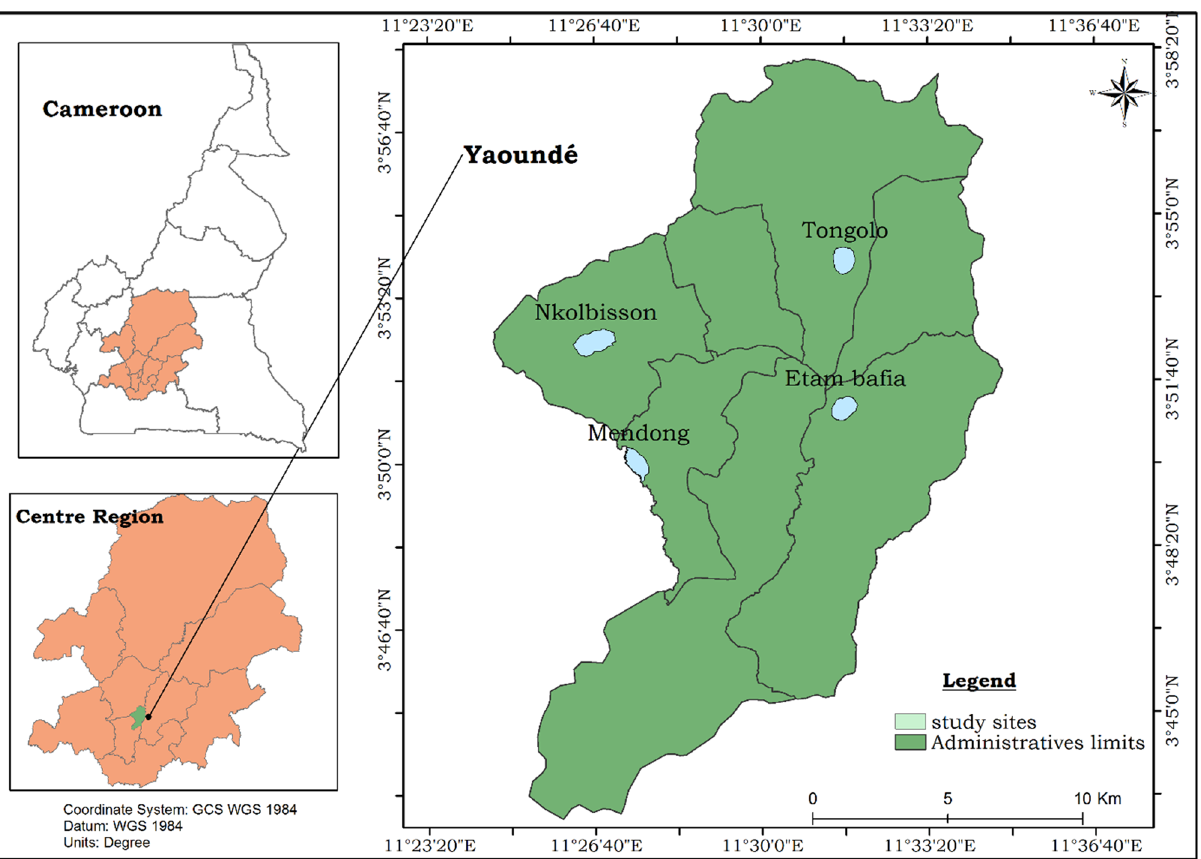
Figure 5. Study sites in the city of Yaoundé, Cameroon. The administrative division of Cameroon is available in open access on the OpenStreetMap platform (https:// www. opens treet map. org/ search? query= camer oon# map=6/ 7. 406/ 12. 283). We used the ArcGIS version 10.2.2 software (ESRI, Redland, CA, USA; https:// www. esri. com/ en- us/ arcgis/ about- arcgis/ overv iew) to generate the map showing study sites in